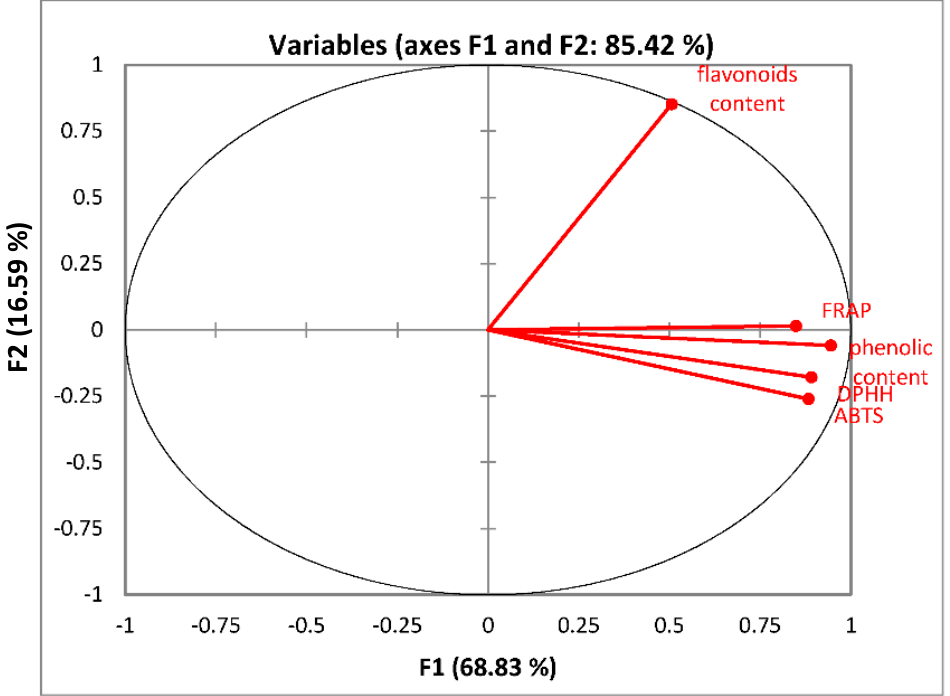
Figure 6. Principal Components Analysis (PCA) between total phenolic content, flavonoid content, and the antioxidant properties DPPH, ABTS, FRAP. Legend: DPPH—radical scavenging test; ABTS— radical scavenging test; FRAP—ferric reducing antioxidant power.